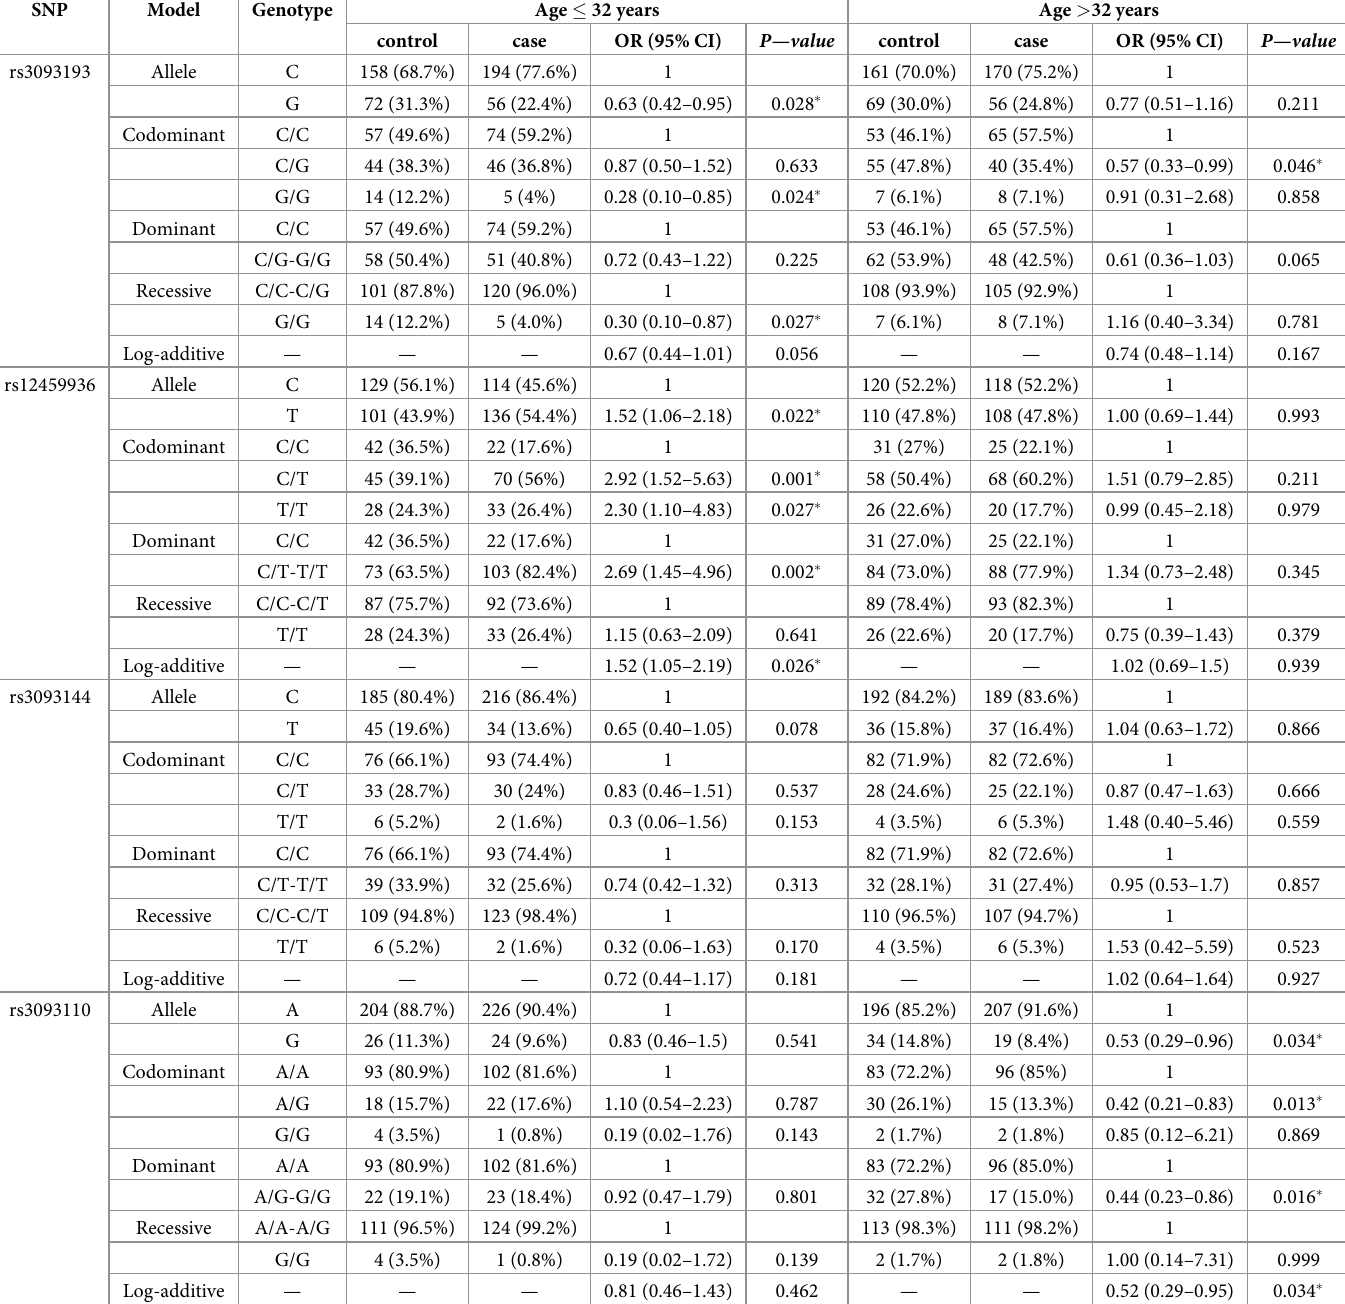
Table 6. Stratified analysis of CYP4F2 gene polymorphisms between age and risk of HAPE.